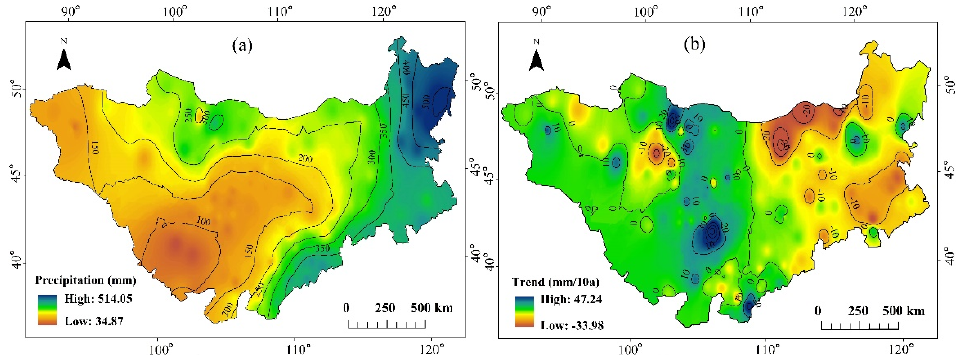
Figure 4. Spatial distribution of annual average precipitation and trend magnitude of 135 stations during 1976–2017 in the Mongolian Plateau (( a ) annual average precipitation, ( b ) trend magnitude in annual precipitation).